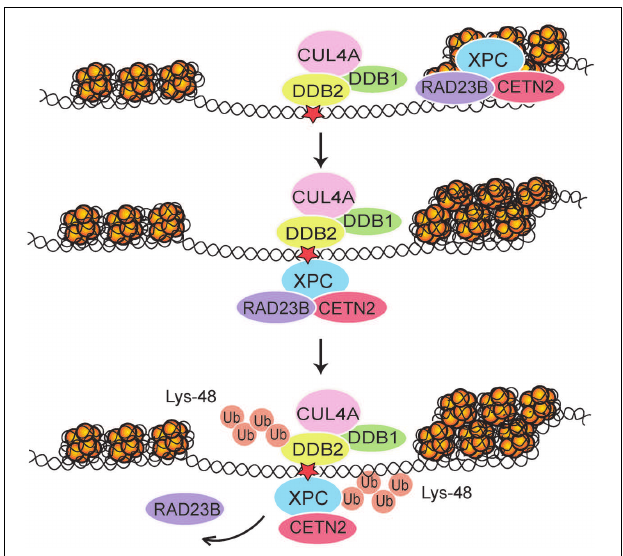
FIGURE 2 | Regulation of XPC localization in chromatin. After each UV pulse, the cullin-type CRL4 DDB2 ligase complex (comprising inter alia DDB1, DDB2, and CUL4A) is recruited mostly to accessible internucleosomal sites in chromatin. The ensuing modification of XPC with Lys48-linked ubiquitin (Ub) chains leads to a temporary retention of XPC on internucleosomal DNA, thus reducing its constitutive association with nucleosome core particles (Fei et al., 2011). Subsequently, RAD23B is released and the XPC-CETN2 heterodimer provides a platform for recruitment of the TFIIH complex. The UV radiation damage is symbolized by a red star.